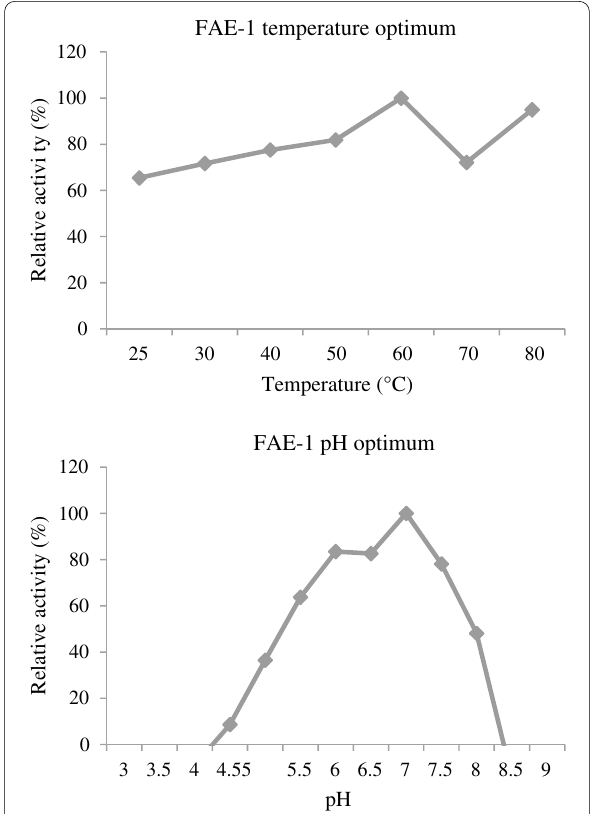
Fig. 1 The temperature and pH optimum of FAE-1. The release of p -nitrophenol was used to determine the relative activity during the hydrolysis of p NP-acetate. Values are represented as mean values SD (n 3) ± =